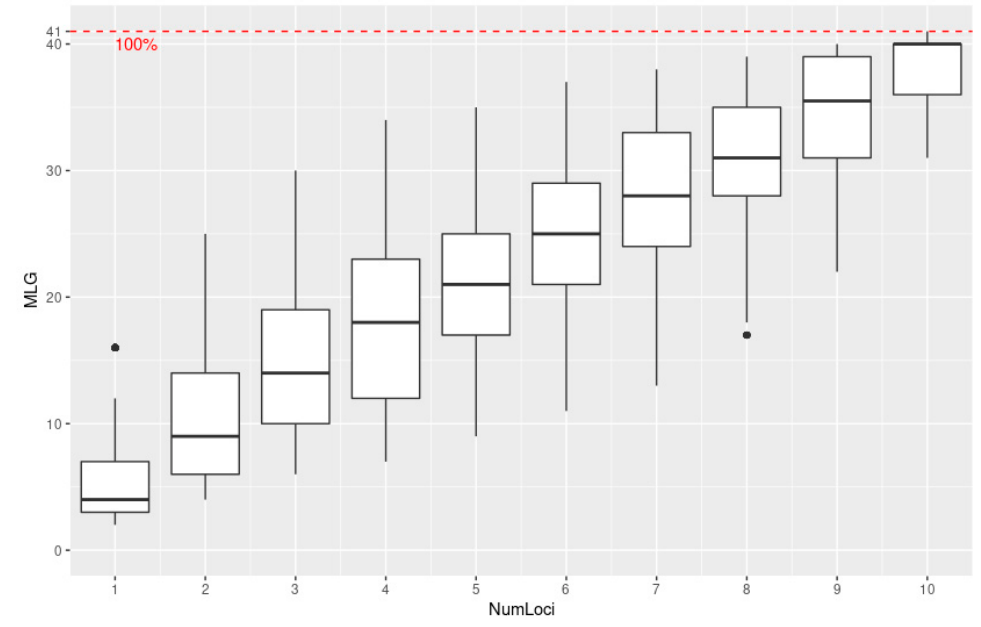
Figure 5. The genotype accumulation curve. Numloci is the number of SSR loci and MLG is the number of multi-locus genotypes. The resolution of MLG is 100% as shown in the dashed red line. The SSR marker data showed that all 152 P. infestans isolates belonged to the lineage EU_23_A1 and 27 MLGs were discriminated within this lineage. The majority of isolates (68) were grouped into MLG_21 (named as sub-clonal lineage 23_A1_19 in Table S2), followed by MLG_33 (29) and MLG_28 (14) as sub-clonal lineages 23_A1_12 and 23_A1_10, respectively. There were fewer than ten isolates in all other MLGs (Table S2). The highest number of genotypes (24) was identified in 2014, followed by only 9, 2 and 3 genotypes in 2013, 2016 and 2018, respectively. Among the 27 MLGs, 15 were detected only once, of these 4 and 11 were identified in 2013 and 2014, respectively. Only the genotype MLG_21 was identified in all sampling years during this study. The genotypes MLG_28 and MLG_33 had been detected in Egypt from 2011. Five genotypes (MLG_14, MLG_15, MLG_21, MLG_28, and MLG_33) were identified in 2013 and 2014. The genotypes MLG_11 and MLG_17 were exclusively found in season 2014, while the genotype MLG_20 was exclusively found